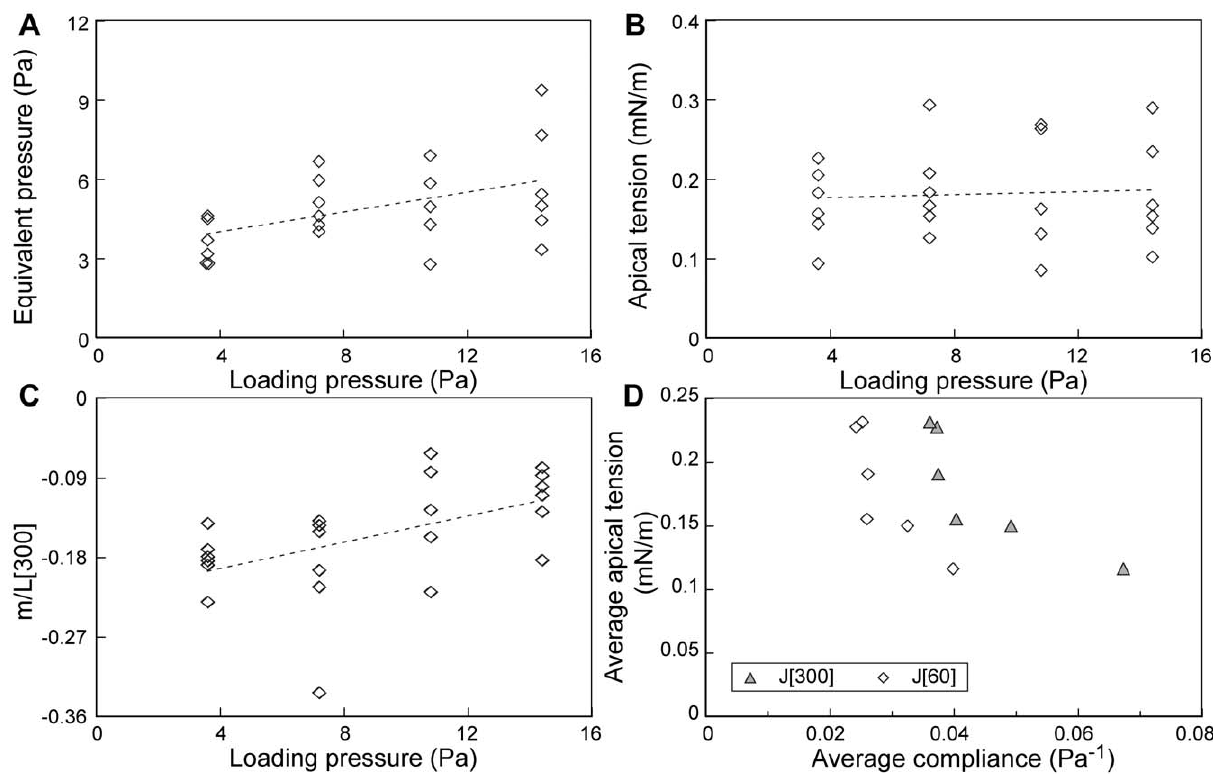
Figure 6. Comparing two models of induced contractions. Loading pressure versus magnitude of induced contractions calculated as A) equivalent pressure, B) apical tension, or C) the ratio of the maximal displacement during the contraction, ‘m’, to the pre-contraction aspirated length, L[300]. Lines for linear least squares fits are shown for clarity only. D) Average compliance for each clutch versus average apical tension for each clutch. Compliance was calculated at 60 s (J[60]) and 300 s (J[300]); n=3 to 4 for each clutch.